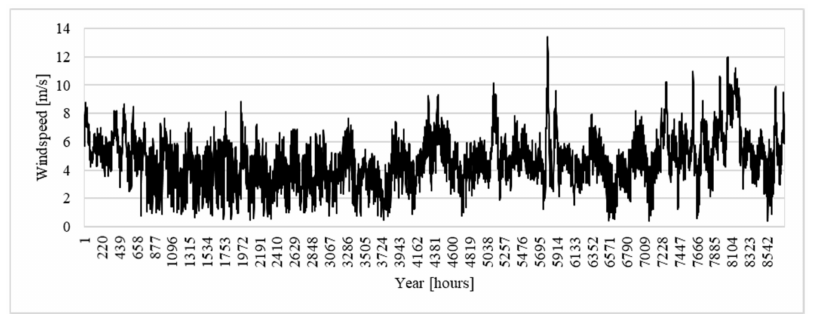
Figure A3. Hourly wind speed in the year 2019 at the model community based on data from [46].